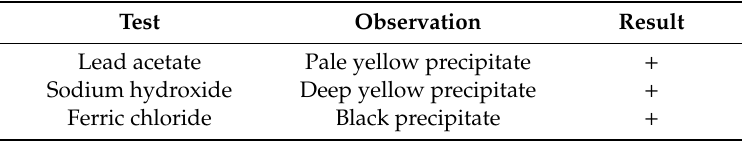
Table 1. Flavonoids test for Pandanus amaryllifolius leaves